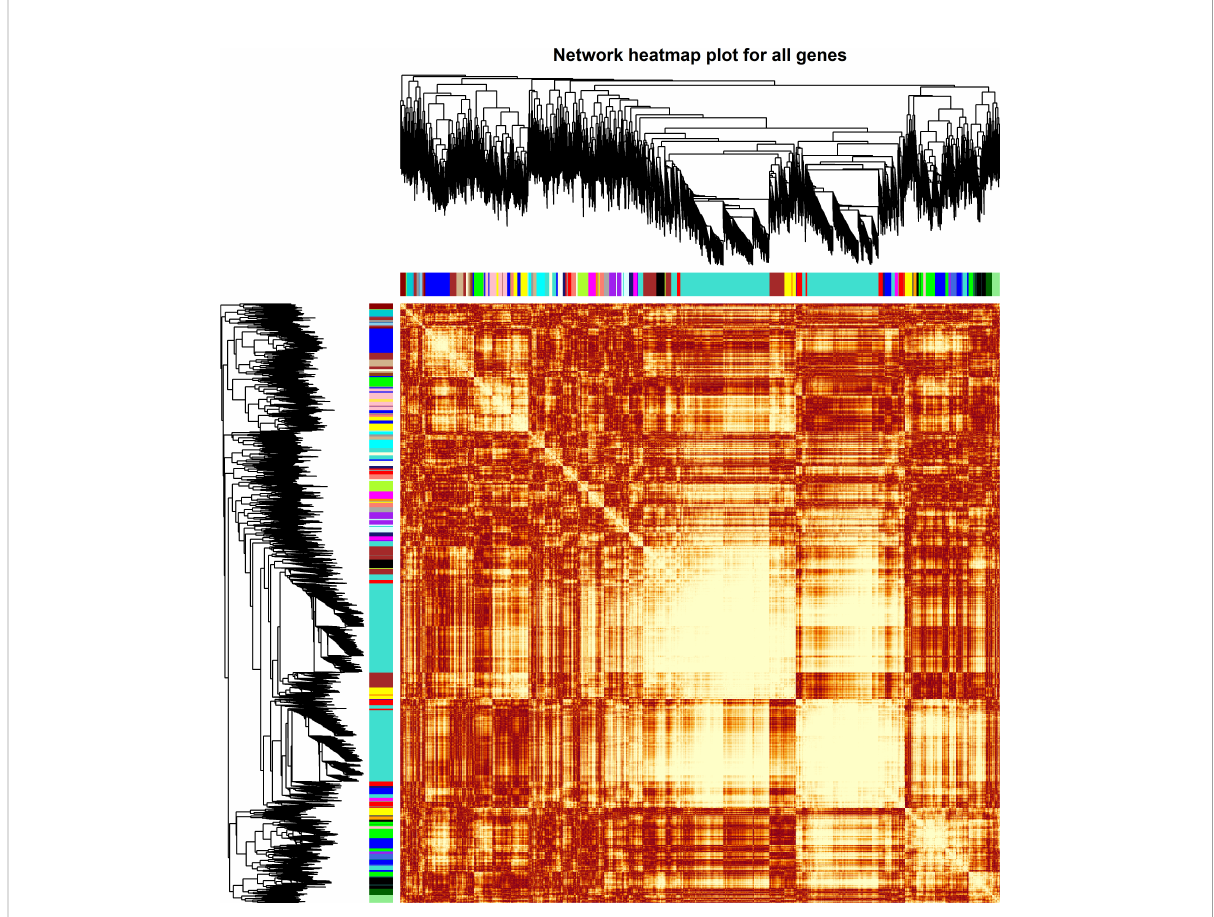
FIGURE 2 Weighted differentially expressed (DE) gene network heat map with assigned modules. The gene dendrogram and module assignment are shown along the left side and at the top, where the genes were clustered in the dendrogram with dissimilarity based on topological overlap and the axe colors indicate the different modules. The color intensity inside the heat map represents the overlap degree, where the lighter color represents a low overlap and the darker red color represents a higher